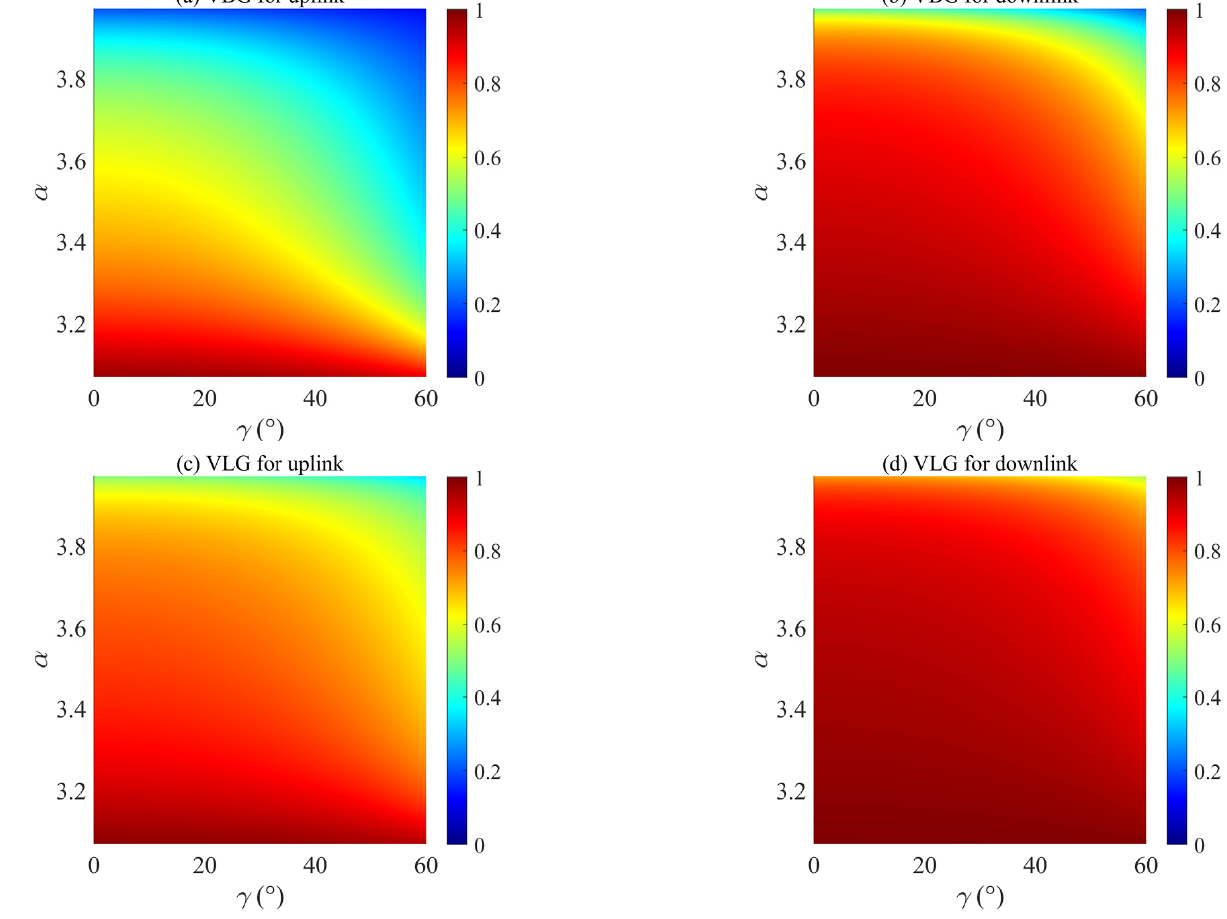
Figure 8. Signal mode detection probability of vector vortex beams versus α and γ for uplink ( a , c ) and downlink ( b , d ) atmospheric turbulence transmissions.